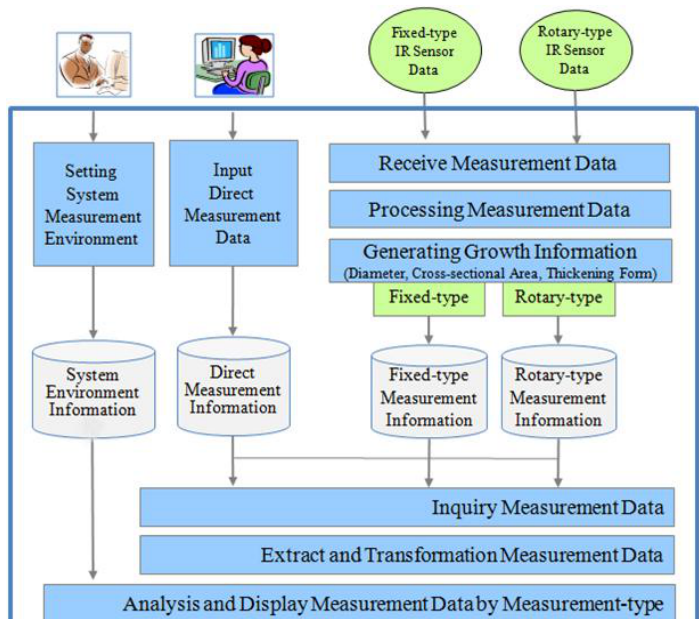
Figure 12. Software Architecture of the